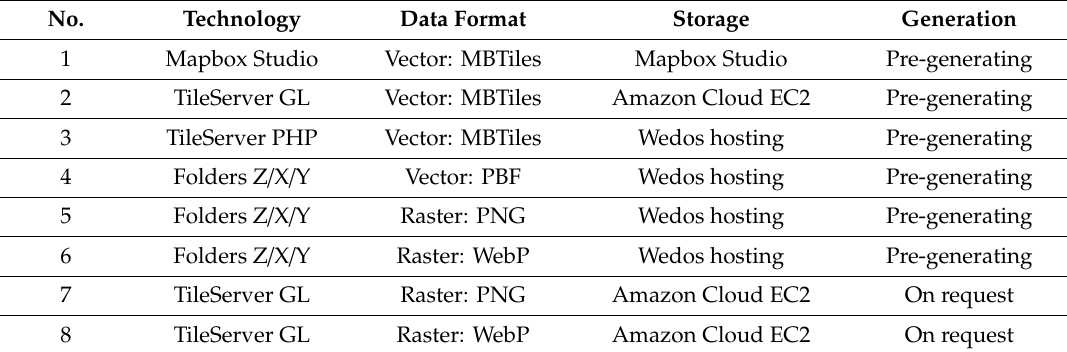
Table 1. Overview of the pilot